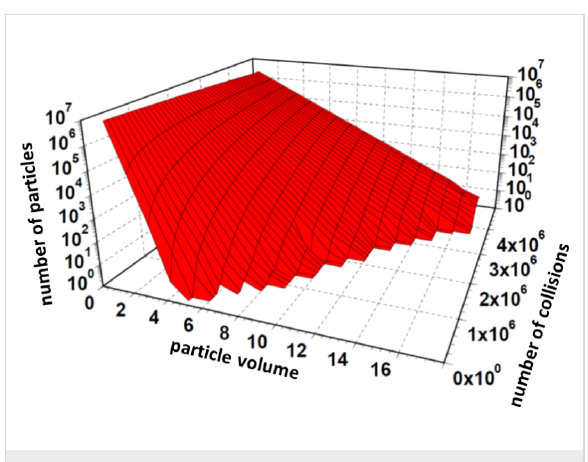
Figure 3: Number of particles as function of the particle volume and the number of collisions. This simulation was started with 10 7 primary particles. The calculations were performed up to 4.7 × 10 6 collisions. For each number of collisions, the distribution function follows obvi- ously an exponential function.